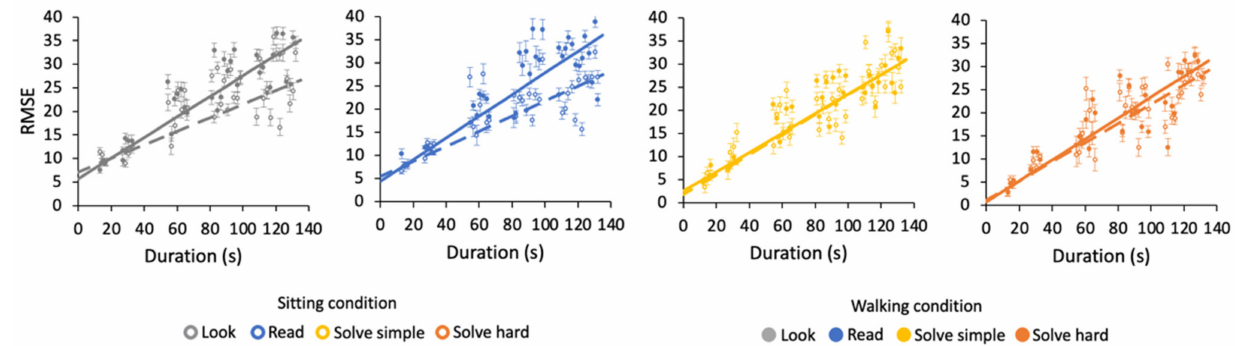
Figure 4. Estimation uncertainty as a function of duration. Averaged RMSE computed on 2 s intervals for all tasks and conditions with their best-fit curves. Different panels correspond to different tasks (see colors in the legend). Sitting condition: open symbols—dashed lines; walking condition: solid symbols—solid lines. Sitting condition—Look: slope = 0.14 ± 0.02, intercept = 4.6 + 0.2; Read: slope = 0.16 ± 0.01, intercept = 4.1 + 0.4; Solve simple: slope = 0.22 ± 0.02, intercept = 1.7 + 0.1; Solve hard: slope = 0.21 ± 0.01, intercept = 0.8 + 0.1. Walking condition—Look: slope = 0.22 ± 0.1, intercept = 4.9 + 0.1; Read: slope = 0.23 ± 0.01, intercept = 3.2 + 0.2; Solve simple: slope = 0.21 ± 0.01, intercept = 1.2 + 0.1; Solve hard: slope = 0.23 ± 0.02, intercept = 0.9 +